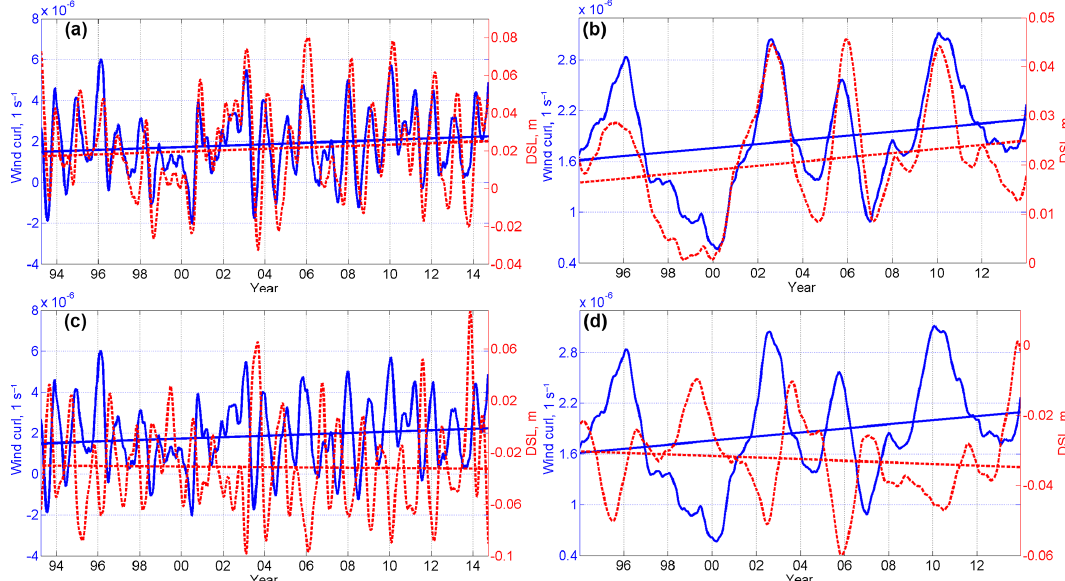
Figure 5. The time series and the linear trends of DSL (red curves) and the basin-averaged wind curl (blue curves): (a, b) at 33.2 ◦ E, 44.8 ◦ N (the basin’s periphery) and (c, d) at 35.4 ◦ E, 44.0 ◦ N (center of the basin); the time series are smoothed (a, c) with a 90-day moving average time series and (b, d) with a 365-day moving average.